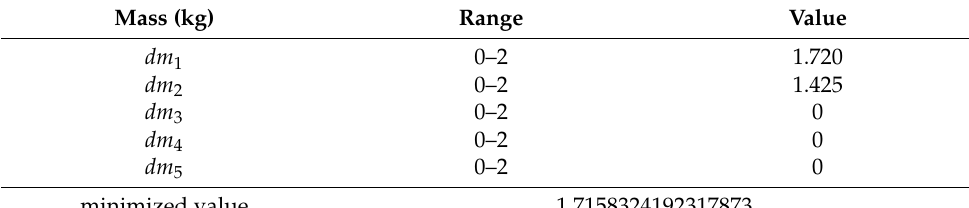
Table 15. Parameters of added masses.